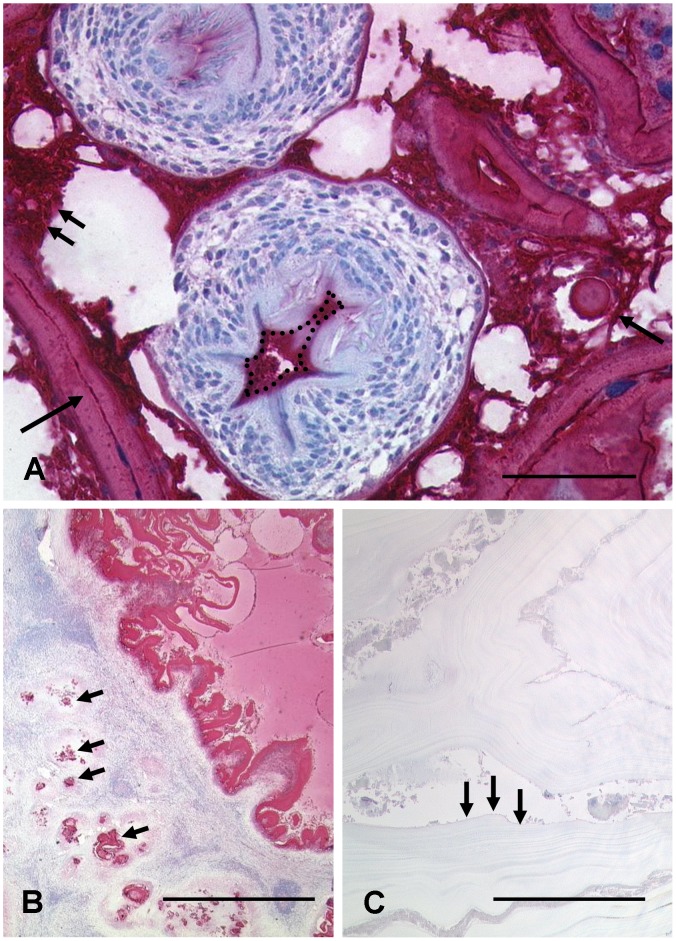
Immunohistochemical staining modalities of the monoclonal antibody (mAb) Em2G11 for metacestodes of Echinococcus multilocularis.
Figure 1A: In metacestodes grown in a Mongolian jird, the antibody strongly marks the laminated layer (single arrow left below). The germinal layer and calcareous corpuscles are strongly stained (two arrows and single arrow right) as well as the precipitated cyst fluid. The area oft the rostellum is superimposed with a positive reacting layer (dashed line) while the inner part of the protoscolex did not react with the monoclonal antibody; bar =  50 µm. 1B, C: In human liver, the Em2 antigen is strongly positive in the slender laminated layer of E. multilocularis. The staining reveals a tubular and infiltrative growth pattern (arrows). In contrast, the laminated layer of E. granulosus is much broader (arrows), no staining is detected by mAb Em2G11; bar =  1000 µm.